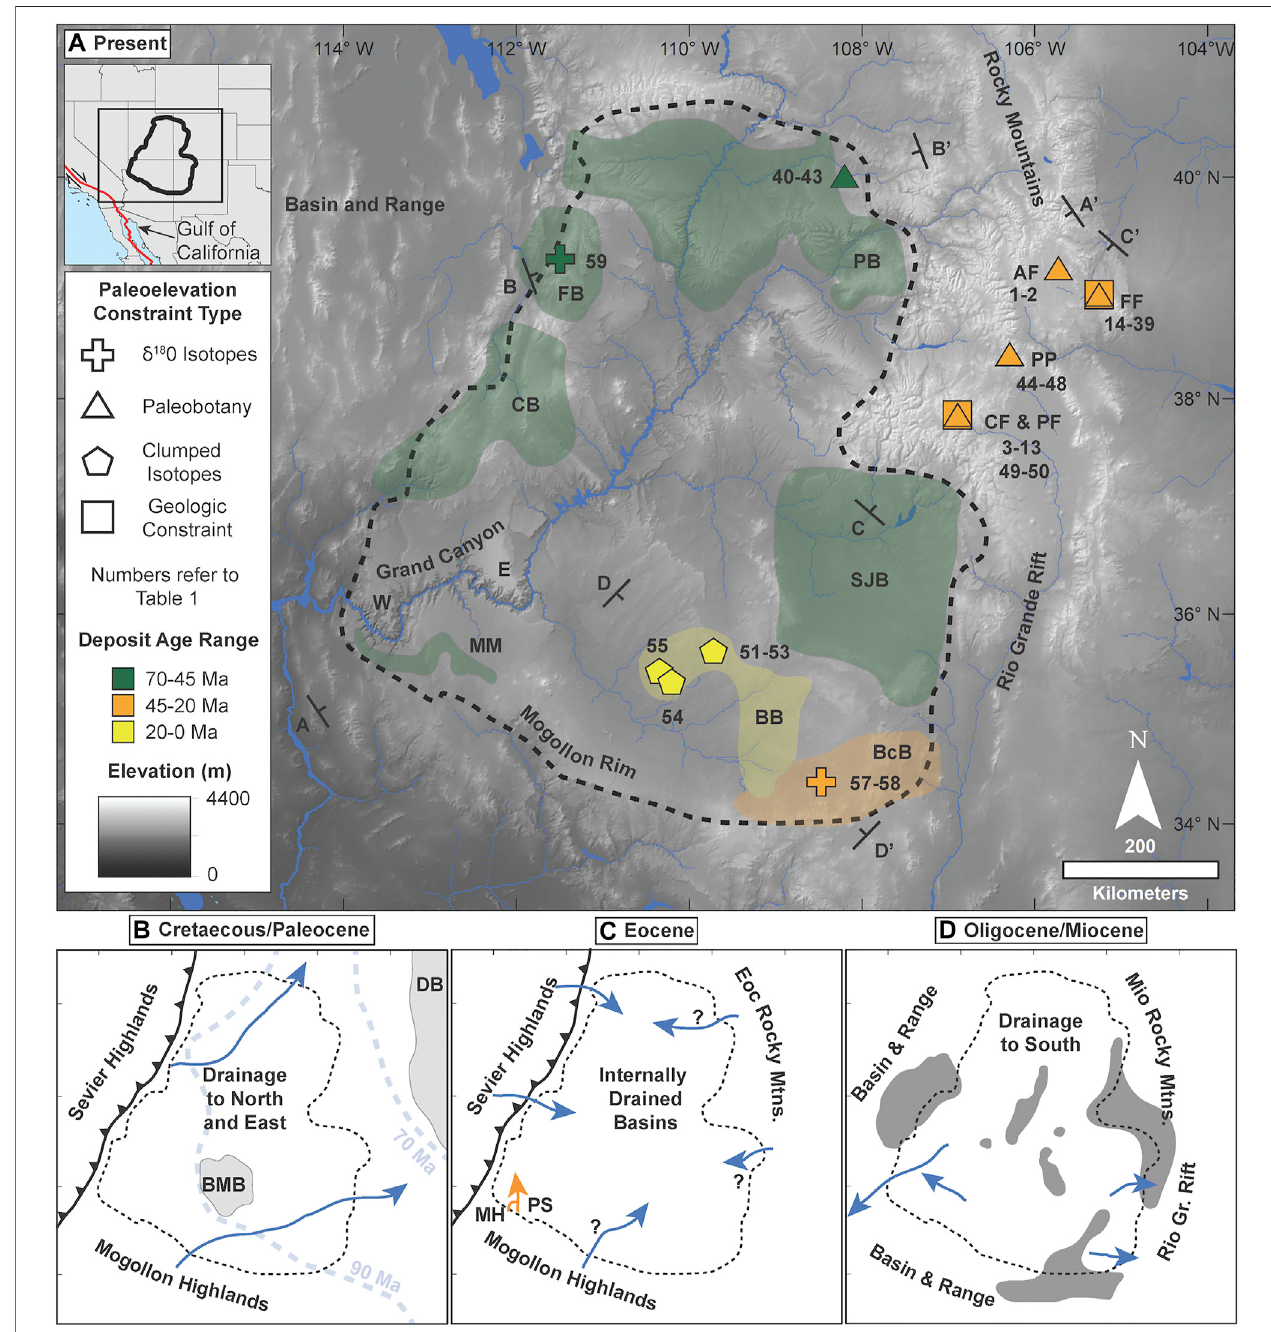
FIGURE 1 | (A) Modern elevation of the Colorado Plateau region with relevant geographic features and depositional basins, locations of paleoaltimetry estimates, andtransectscorrespondingto Figure2 .Symbolsrepresentthepaleoaltimetrymethodappliedateachlocation,andsuperscriptsrefertopaleo-elevationestimateIDin Supplementary Table S1 . SJB (cid:1) San Juan Basin; BcB (cid:1) Baca Basin; BB (cid:1) Bidahochi Basin; MM (cid:1) Music Mountain Formation; CB (cid:1) Claron Basin; FB (cid:1) Flagstaff Basin; UB (cid:1) Uinta Basin; PB (cid:1) Piceance Basin; CF (cid:1) Creede Formation; AF (cid:1) Antero Formation; FF (cid:1) Florissant Formation; PP (cid:1) Pitch-Pinnacle Formation; PF (cid:1) Platoro Formation. (B – D) Relevant paleogeographic reconstructions to provide context for interpreting uplift of the Colorado Plateau region (see Overview section for discussion). (B) In the Late Cretaceous-Paleocene, evidence of the Laramide orogeny and uplift of the CP is marked by the disappearance of marine deposits (gray shading with inferred paleo-shoreline contours based on deposit ages; BMB (cid:1) Black Mesa Basin; DB (cid:1) Denver Basin - Fox Hills Group). The Sevier thrust front schematically shows the edge of the Sevier highlands and marks the western boundary of the CP. (C) By the Eocene, North- fl owing paleocanyons had incised the southwestern plateau (orange arrows; MH (cid:1) Milkweed-Hindu, PS (cid:1) Peach Springs). Uplift to the north and east caused internal drainage and drainage reorganization (blue arrows). (D) In the Oligocene-Miocene, there was widespread volcanism (gray shading) on the edges of the CP. Continental extension and normal faulting to the West and South (Basin and Range, Rio Grande Rift) caused a drop in base-level and aided drainage reversal to the southwest (blue arrows). Paleogeographic reconstructions were adapted from these compilations: Hunt, 1956; Potochnik et al., 2001; Davis et al., 2009; Cather et al., 2012; Young and Crow, 2014; Hill et al., 2016; Karlstrom et al.,